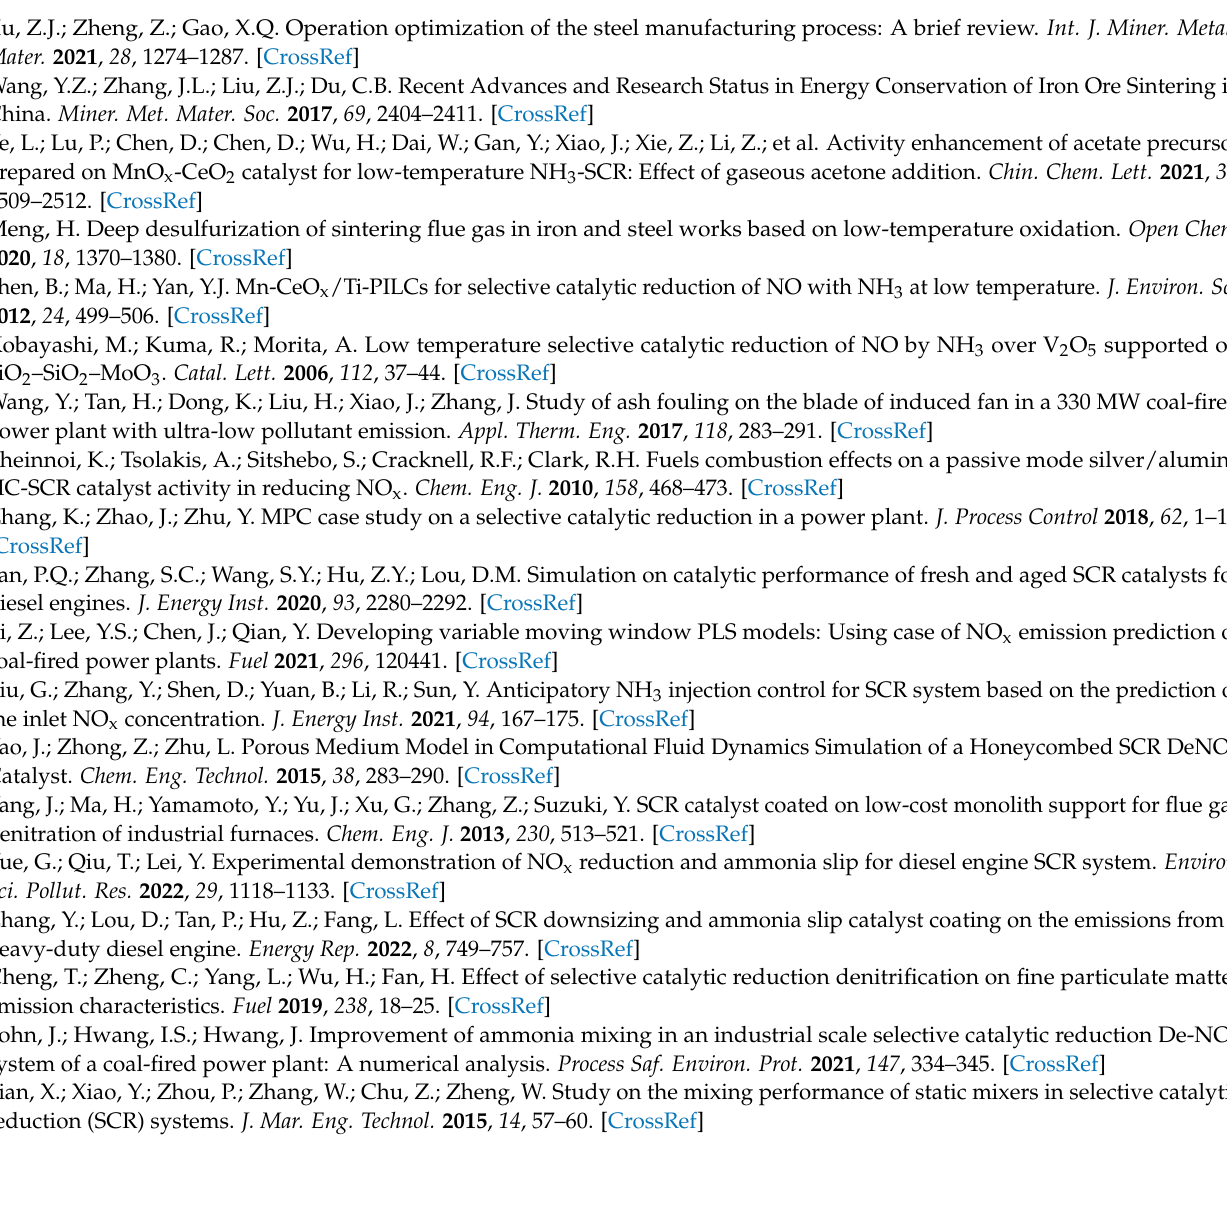
catalyst macro model, Figure S3. Comparison between numerical simulation results and experimental results based on [1], Figure S4. Comparison of meso (b) and macro (a) simulation velocity of catalyst, Figure S5. Comparison of meso (b) and macro (a) simulation NO concentration of catalyst, Figure S6. Nonuniform velocity inlet distribution, Figure S7. Comparison of meso (b) and macro (a) simulated velocity of catalyst under nonuniform inlet conditions, Figure S8. Comparison of meso (b) and macro (a) simulated NO concentration of catalyst under nonuniform inlet